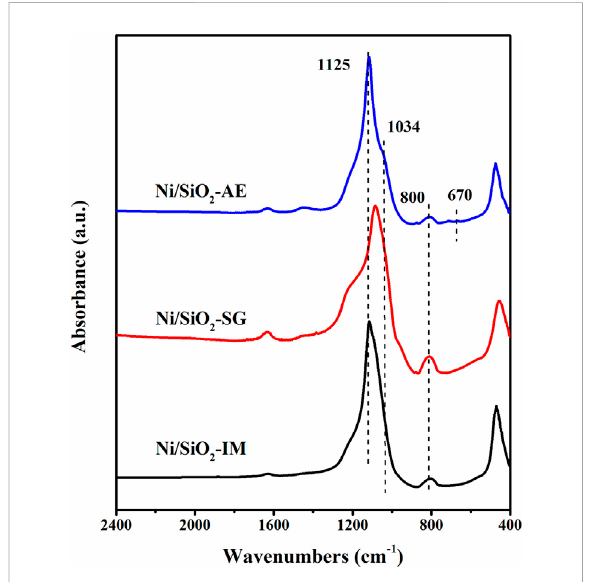
FIGURE 3 FT-IR spectra of Ni-based catalysts prepared by different methods.